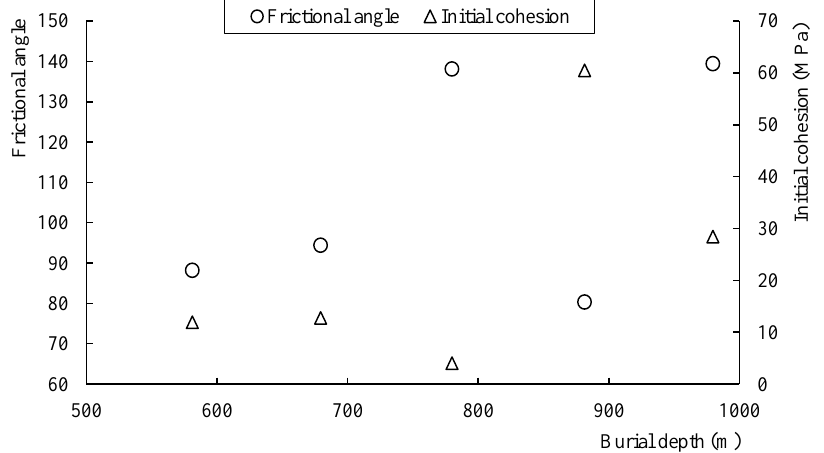
Figure 10. Relationships between the parameters of the model and burial depth.